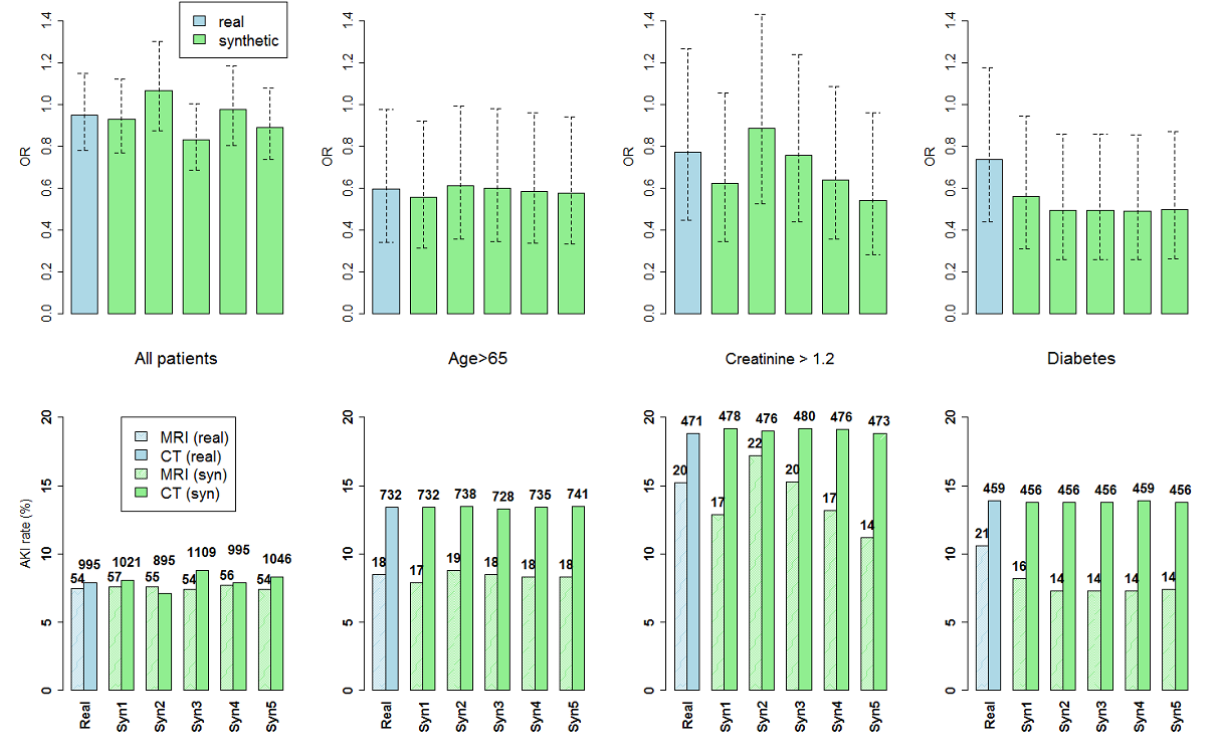
Figure 6. Acute kidney injury (AKI) rates (lower panel) and odds ratios with 95% confidence intervals (upper panel) in four different subgroups for the real data and five repeatedly generated synthetic datasets (Syn1-Syn5). The number of patients in the data for each subgroup is shown above the rate bars. Results obtained from the synthetic data were generally consistent with those obtained from the real data. AKI rates were well estimated for patients older than 65 years of age, and the borderline statistical difference remained consistent; AKI rate estimates were less stable for patients with high creatinine, yet the conclusion of no statistical difference was consistent; Odds ratios for diabetic patients were under-estimated due to under-estimated AKI rates for the very small number of diabetic patients that underwent